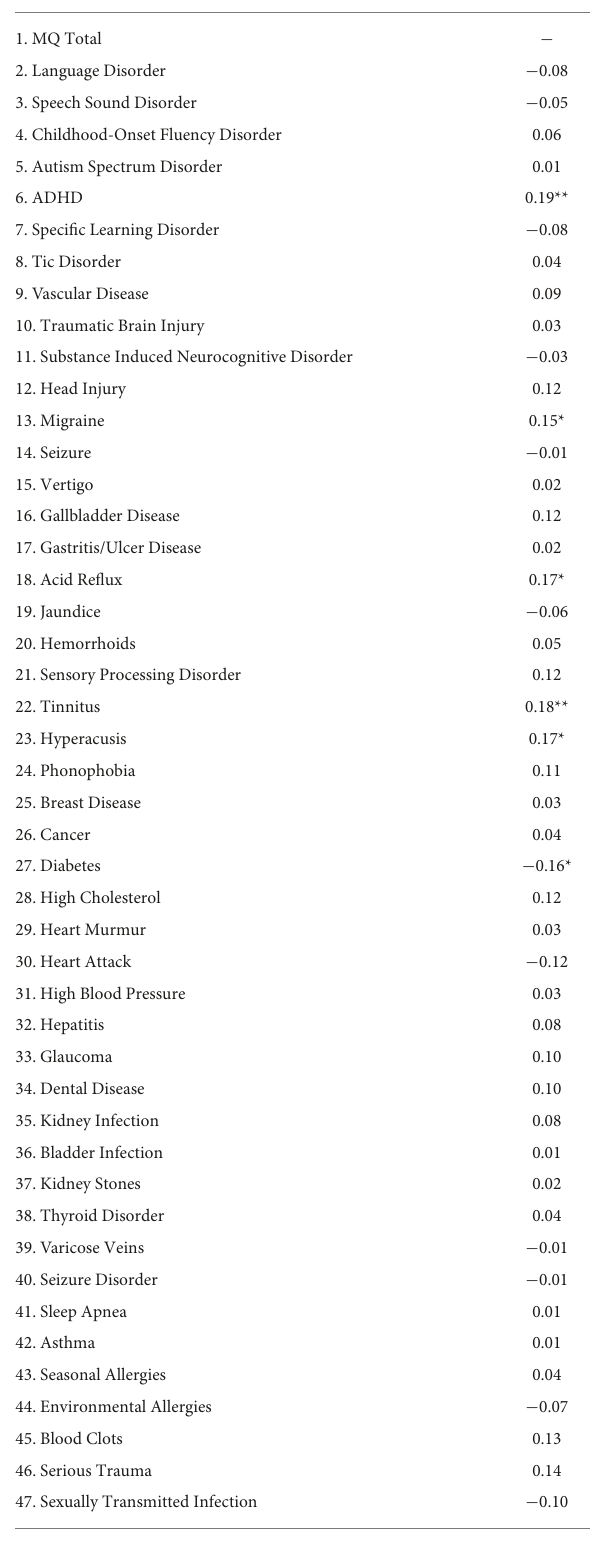
TABLE 4 Correlations between total score on the Misophonia Questionnaire (MQ) and personality disorder (PD) dimensional profiles.